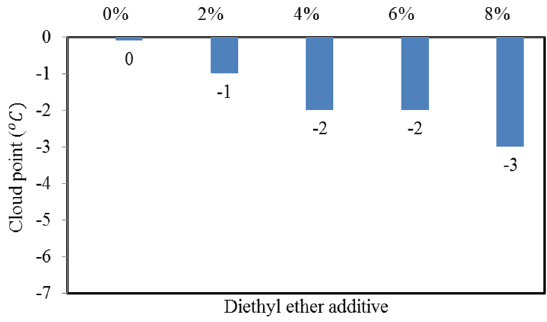
Figure 6. Effect of increasing diethyl ether percentage on blended B30 fuel cloud point.